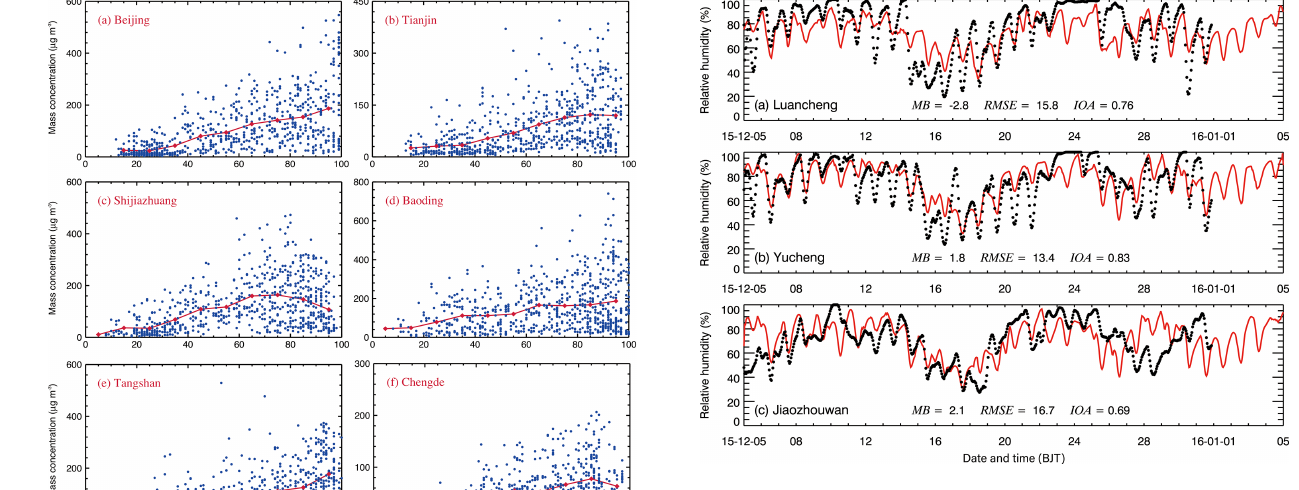
Figure 3. Comparison of measured (black dots) and predicted (red line) diurnal profiles of the RH in (a) Luancheng, (b) Yucheng, and (c) Jiaozhouwan from 5 December 2015 to 4 January